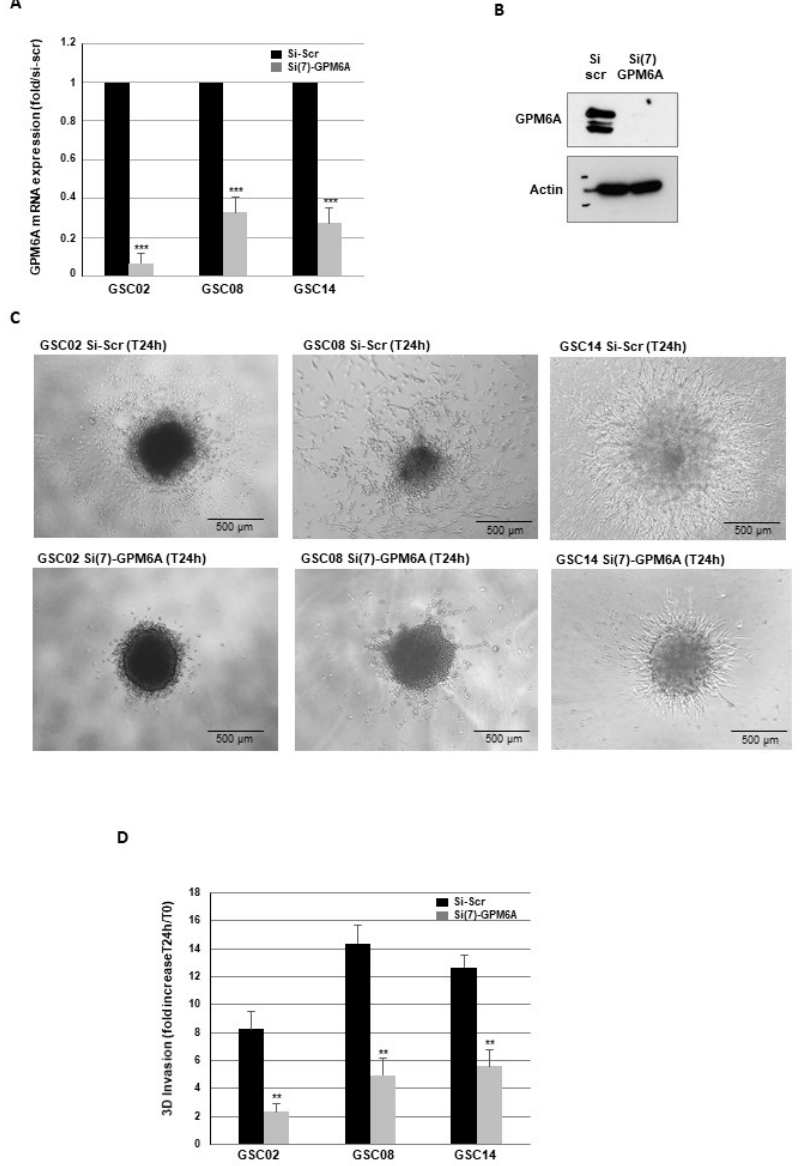
Figure 4. Blocking GPM6A gene expression represses invasion of GBSC. Primary neurospheres from different invasive GB biopsy specimens (GSC02, GSC08, GSC14) were transfected with a specific GPM6A siRNA (si(7)-GPM6A) or a scramble control (si-Scr). GPM6A expression was analyzed by real-time PCR ( A ) or Western blot ( B ). ( C , D ) Three-dimensional invasion assays were performed as described in the Methods. Images are representative of three independent experiments. Quantification of 3 experiments are presented as means ± SD. *** p < 0.001; ** 0.001 < p < 0.01.